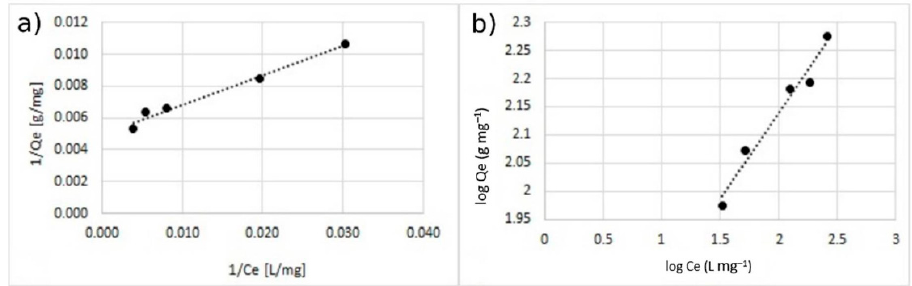
Figure 11. Adsorption isotherm for adsorption of Cu 2+ using MA with 10% w/w of the coating. ( a ) Langmuir model and ( b ) Freundlich model.